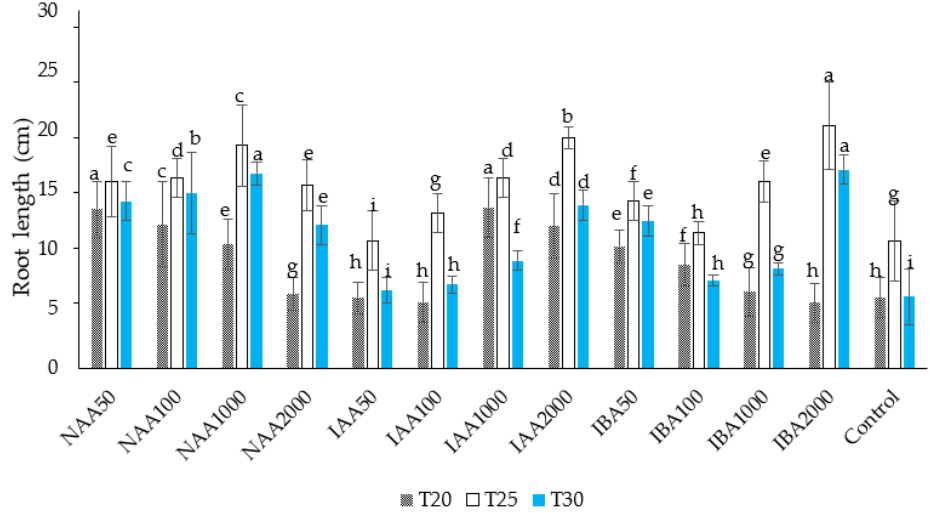
Figure 4. The effect of auxin concentration on an average root length in C. indicum. Different letters indicate statistical differences as assessed by Duncan’s multiple comparison tests ( p < 0.05).